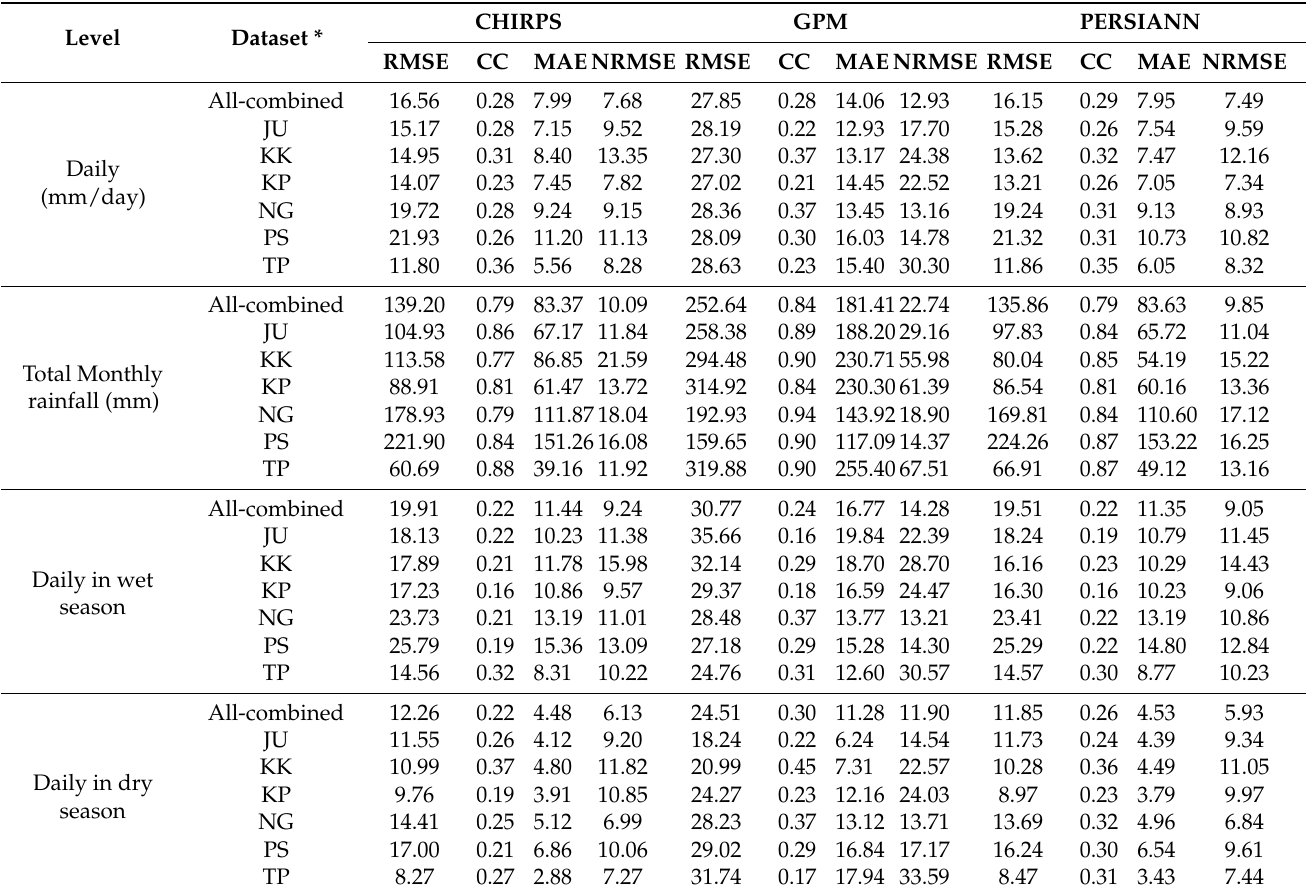
Table 5. Summary of quantitative accuracy measures from three satellite rainfall products. Data calculated with outliers